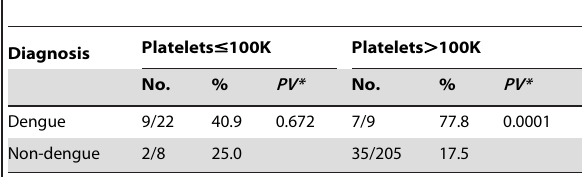
Table 4. Percent of positive tourniquet tests for lab-confirmed dengue versus non–dengue patients by platelet